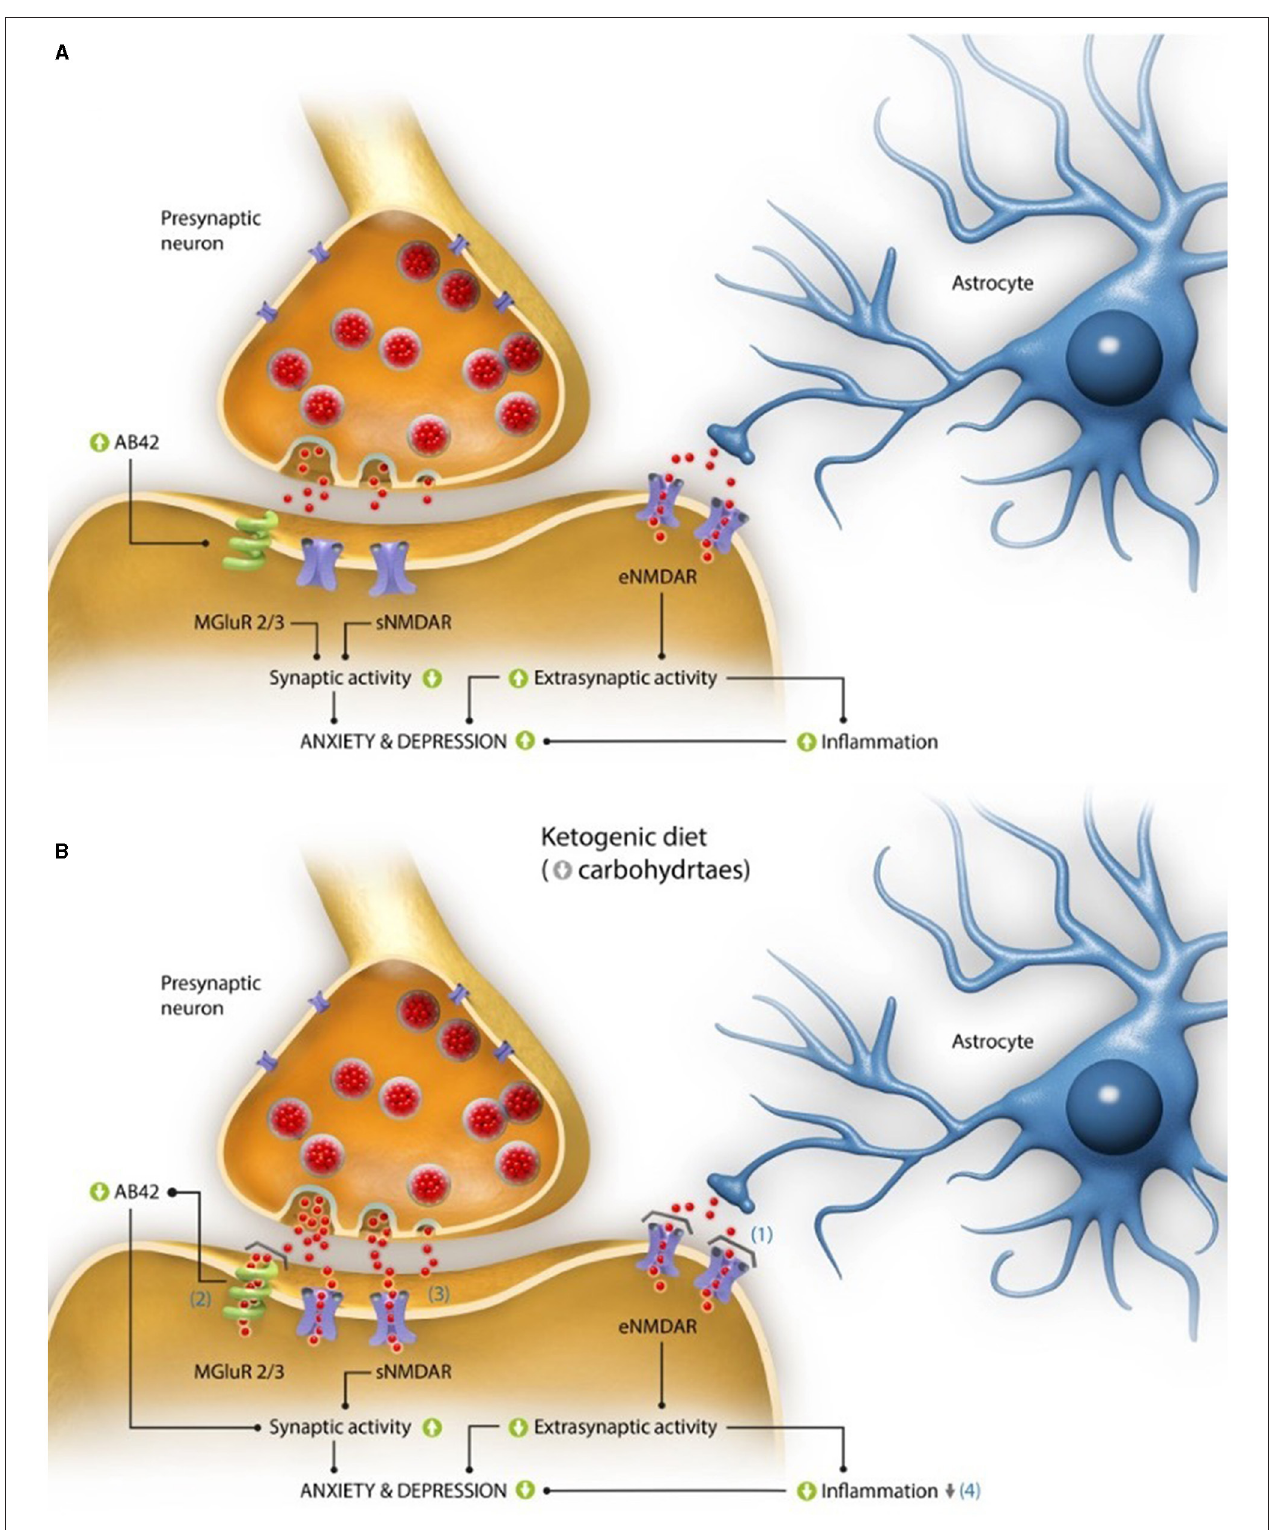
FIGURE 1 | Interaction of glutamate activity on alterations in anxiety and depression levels characteristic of the disease. (A) Pathogenic mechanisms based on the activity of the excitatory neurotransmitter glutamate both at synaptic and extrasynaptic levels, which could explain the elevated perception of anxiety and depression described in Alzheimer’s disease (AD). At the synaptic level, in the animal model of the disease 3xTgAD mice the activation of mGluR2/3 receptors due to excess